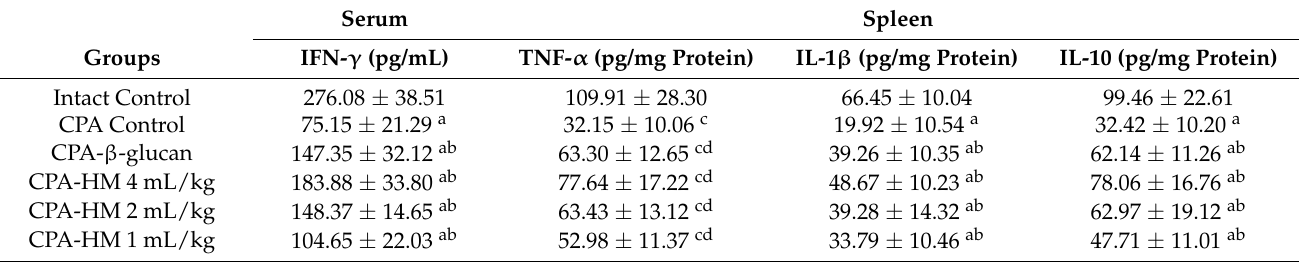
Table 3. Changes in the serum and splenic cytokine contents following hemomine treatment in intact or CPA-induced immunosuppressed